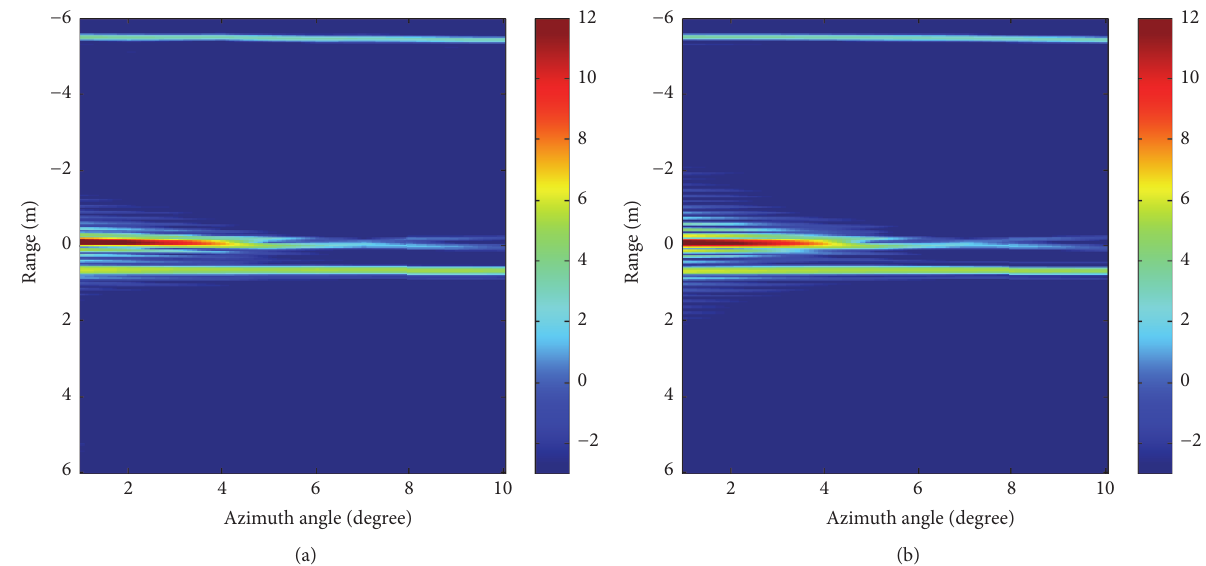
Figure 14: RP history of target II. (a) Simulated RP history of target II; (b) real RP history of target II.